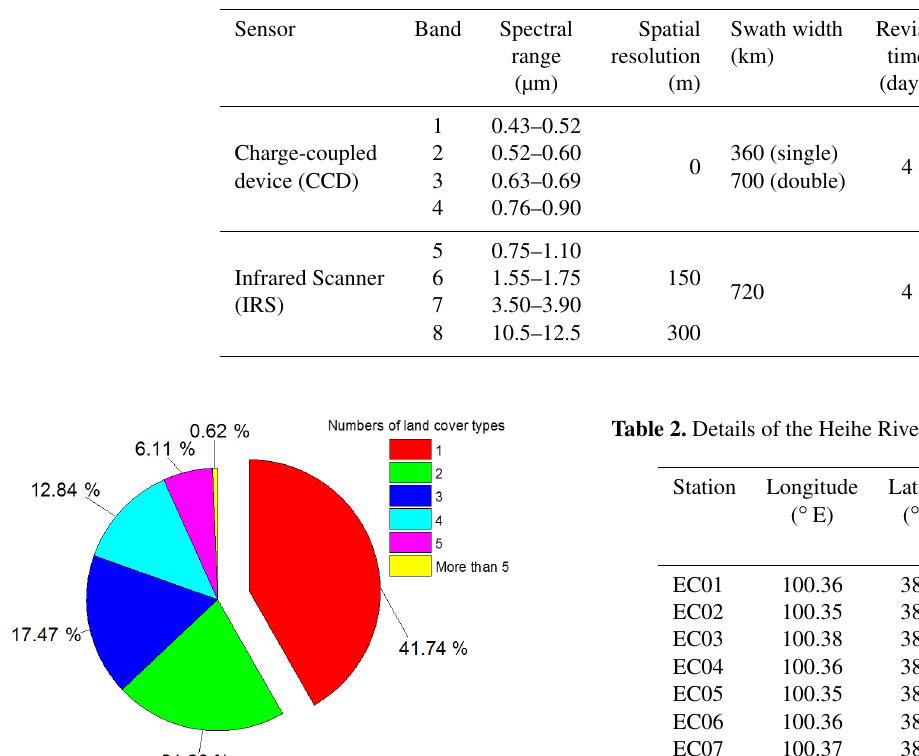
Table 1. Specifications of the HJ-1B main payloads.